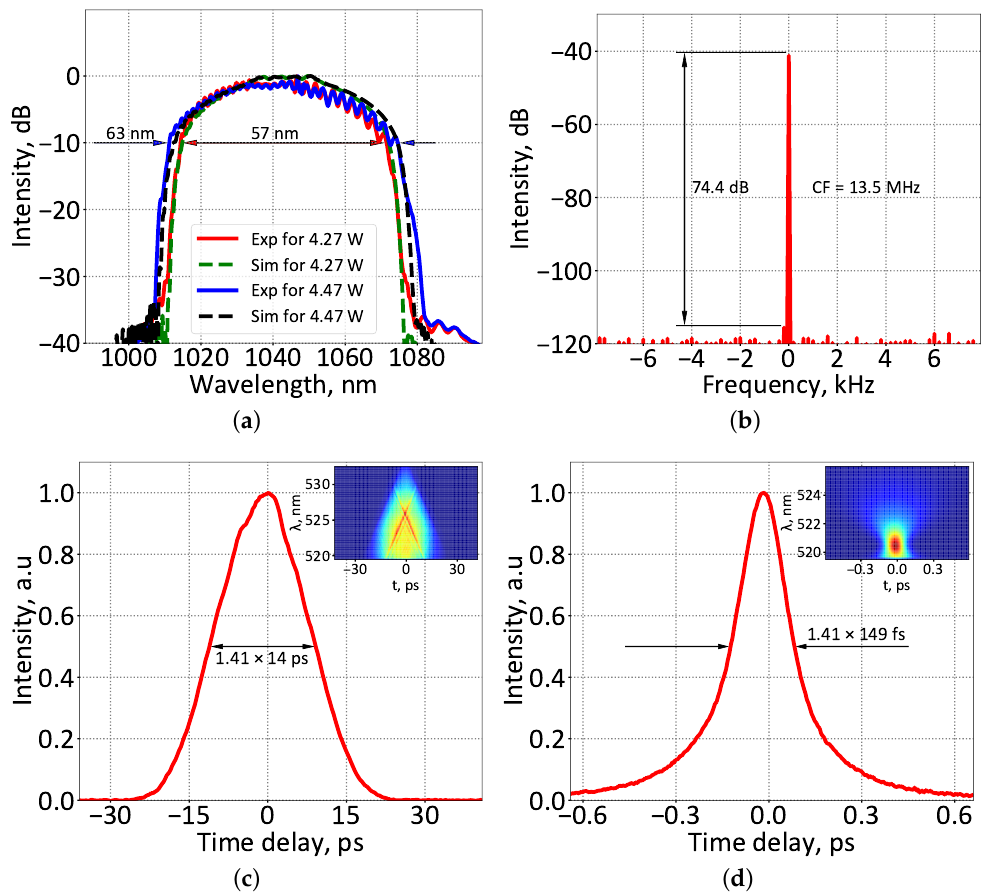
Figure 2. Parameters of the pulses: normalized optical spectra for the 4.3 W of the pump power (solid red line) and 4.5 W (solid blue line), the dashed lines represent the results of numerical simulations ( a ); RF spectrum ( b ), CF—central frequency; autocorrelation function with corresponding FROG trace (inset) for the chirped pulse ( c ) and compressed one ( d